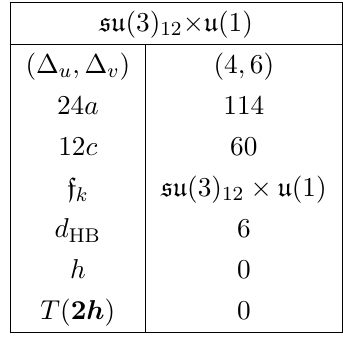
Figure 34. Information about the su (3) 12 × u (1)